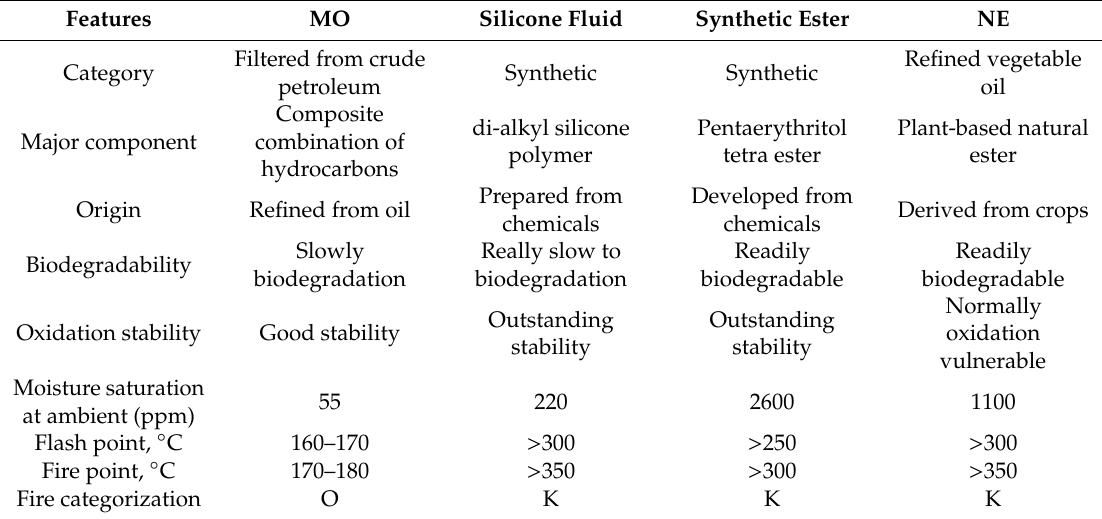
Table 2. Summary of characteristics of insulating fluids applied in HV equipment [5].